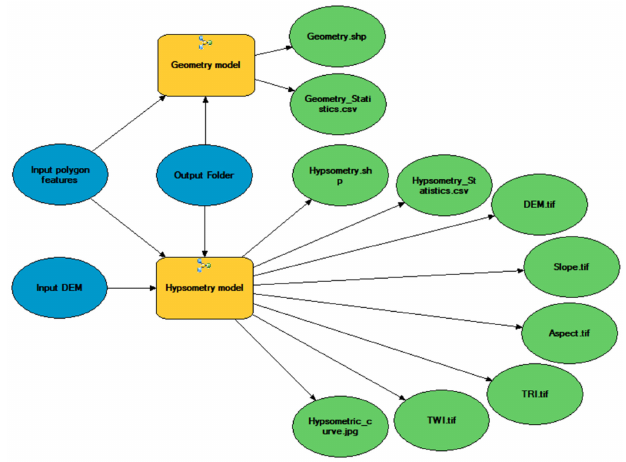
Figure 3. The schematic workflow for the MAT toolbox.